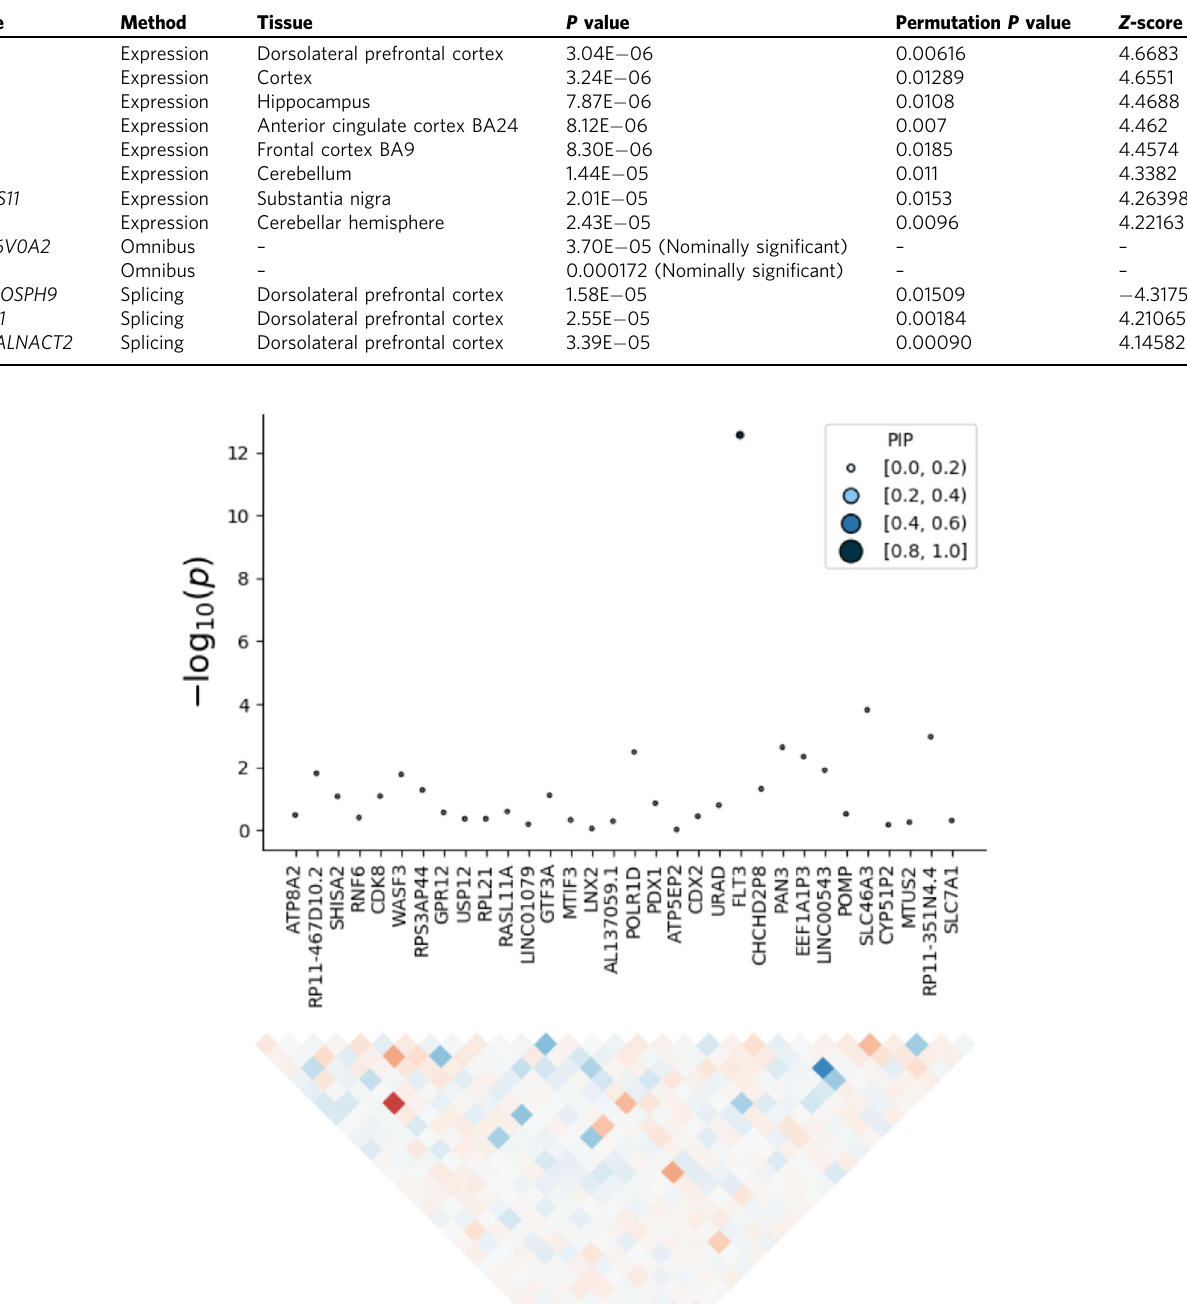
Table 1 TWAS genes with association to Tourette ’ s syndrome.